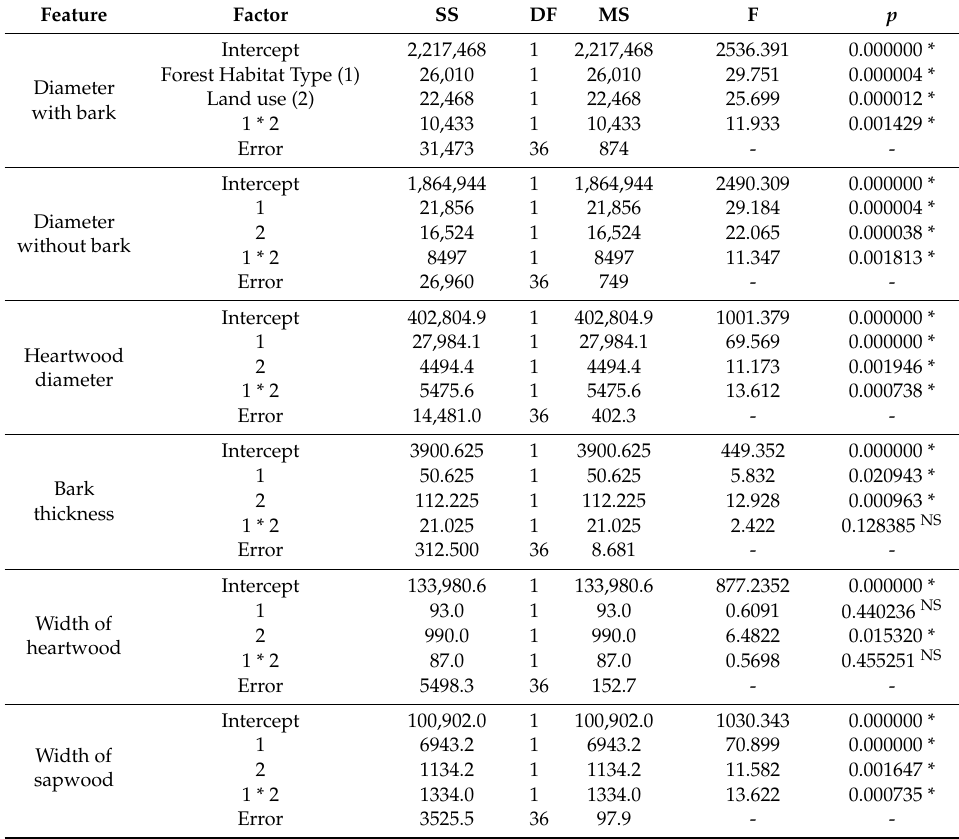
Table 3. Values of ANOVA for pine trunk dimensional features depending on the forest habitat and previous land